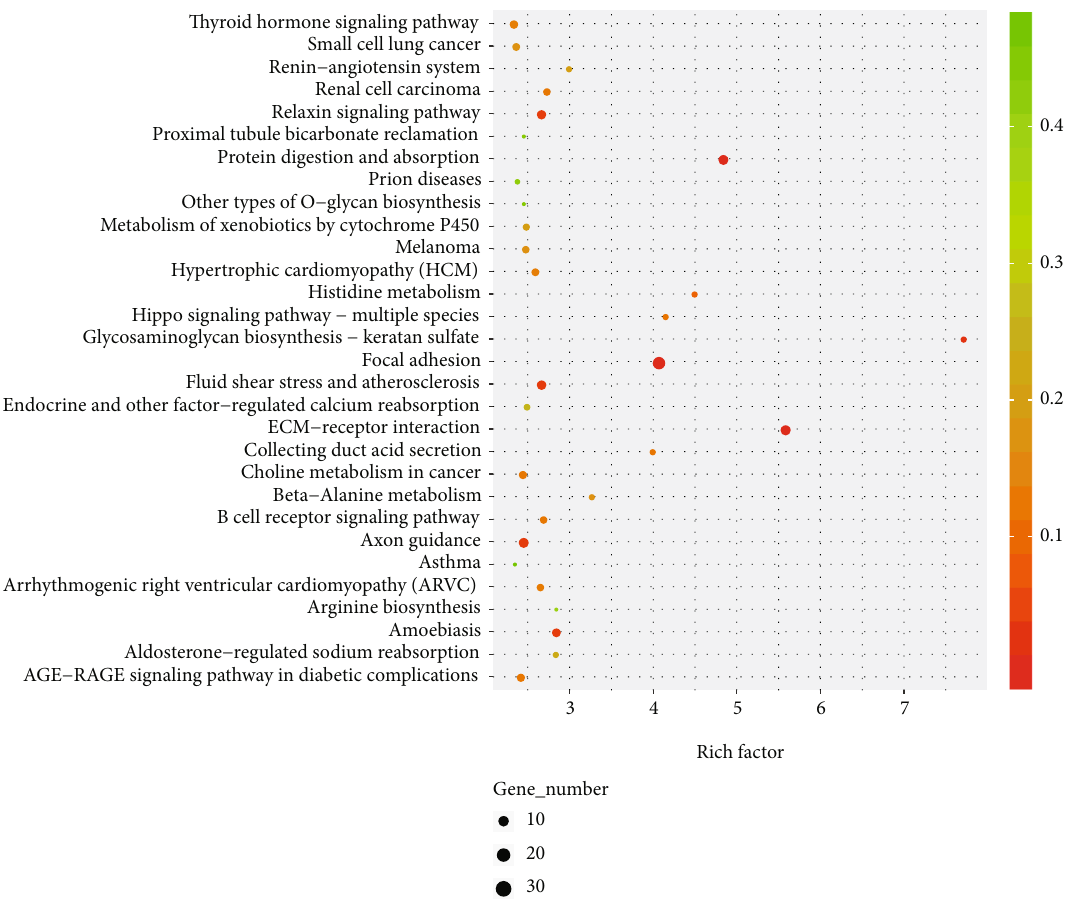
Figure 3: Gene ontology analysis and KEGG analysis of di ff erentiated expressed genes in stria vascularis of Slc26a4